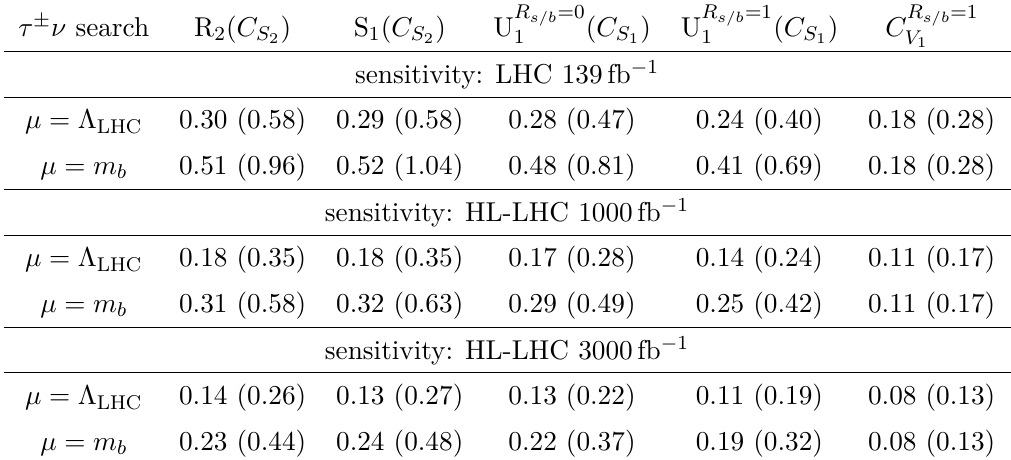
Table 7 . Expected sensitivities of the absolute value of the WCs for cut a in the single LQ scenarios. The sensitivity to C S is shown for R 2 and S 1 , while that to C S 2 with U(2) flavor symmetry. See table 5 for details of the descriptions.